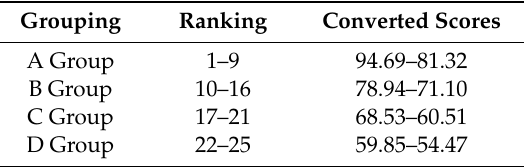
Table 5. AHP results.